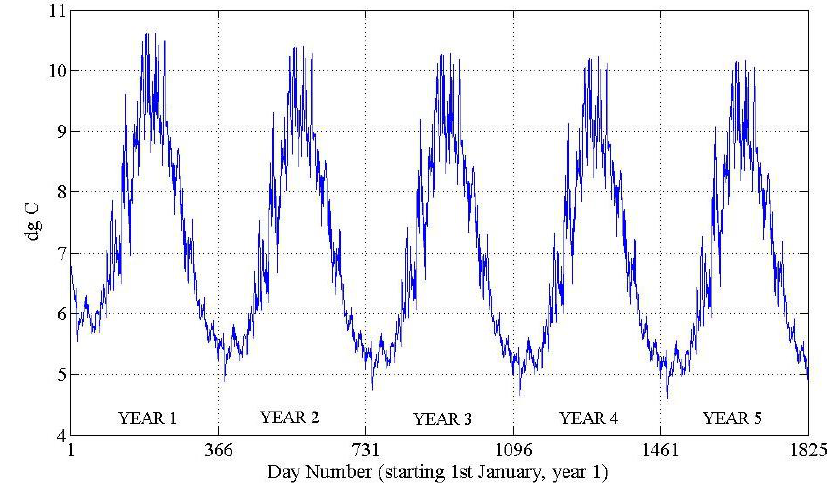
Figure 5. Minimum daily array inlet temperatures (mid-terrace house).